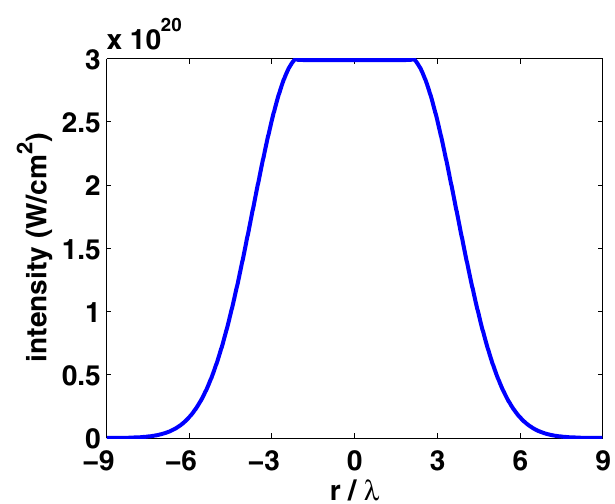
FIG. 7. (Color) Spatial laser intensity profile used in 2D3V PIC simulations. This profile has 5 (cid:6) m plateau in the central part and it is Gaussian on both sides of the plateau (with the characteristic scale of 2 : 9 (cid:6) m